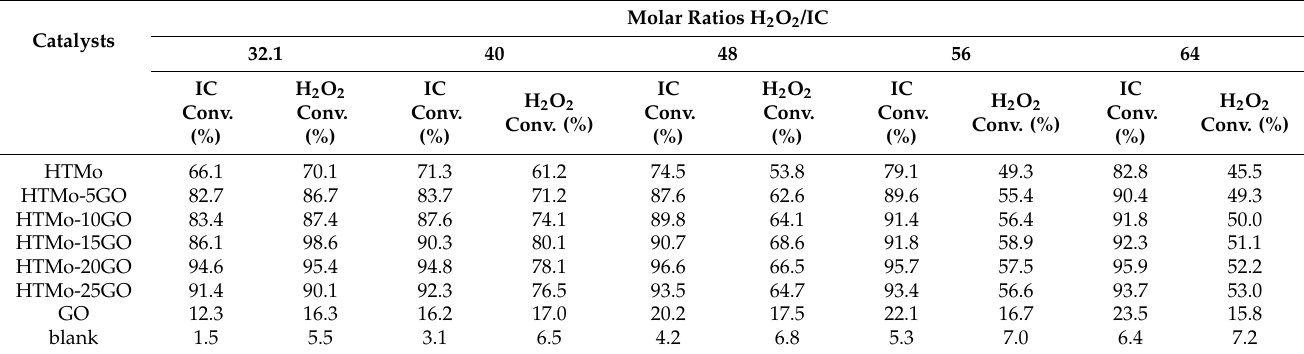
Table 5. The conversion of IC and H 2 O 2 using HTMo-xGO catalysts at different molar ratios H 2 O 2 /IC